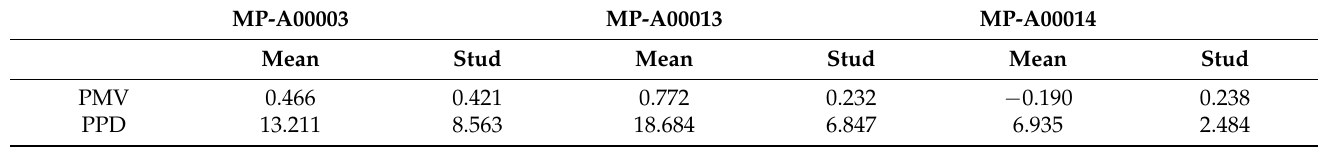
Table 8. Average thermal comfort values for the three platforms in